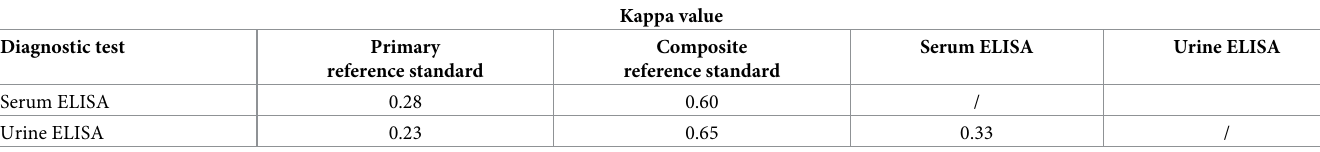
Table 4. Test for agreement between two diagnostic